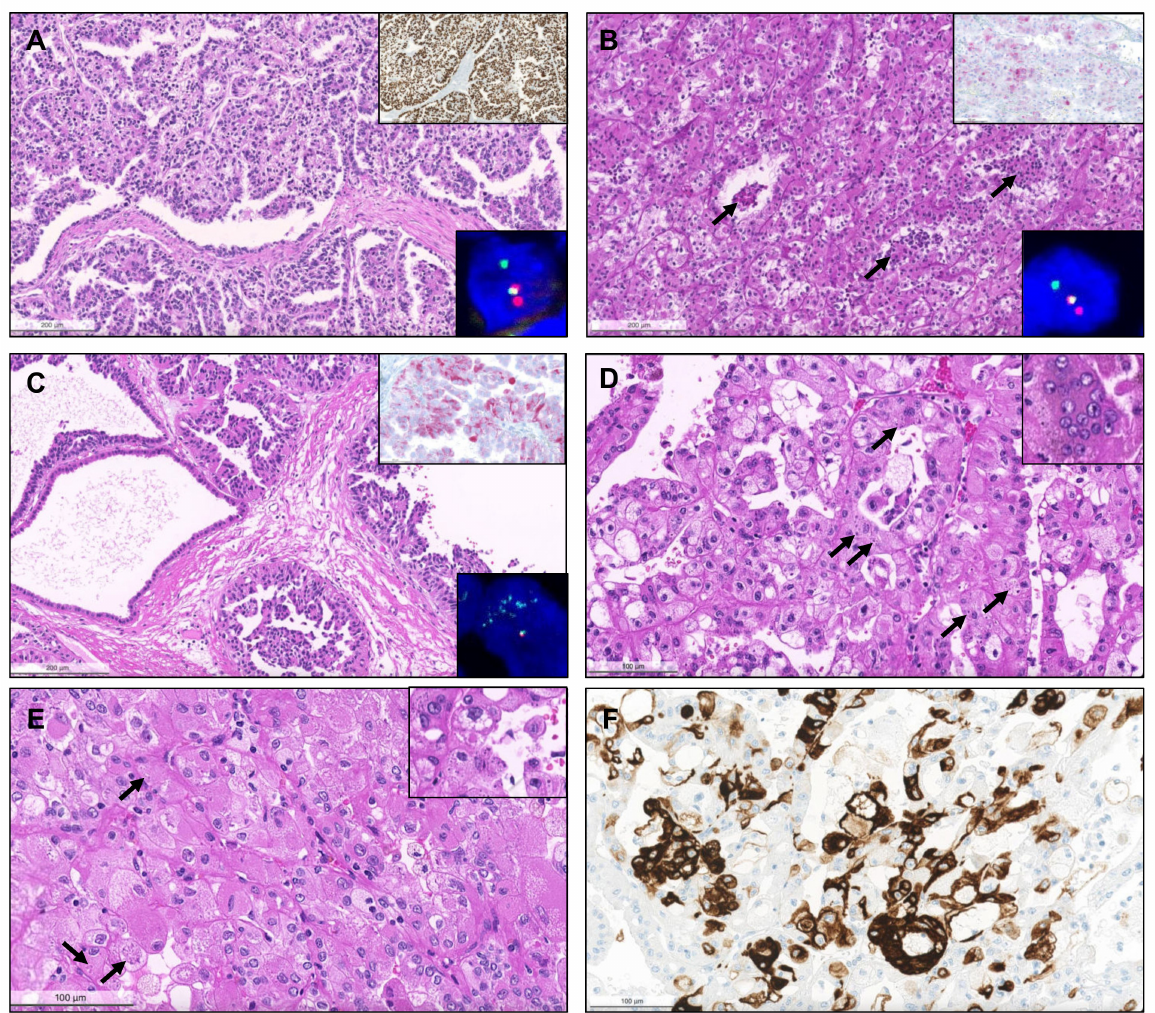
Figure 10. TFE3-translocated renal cell carcinoma. The tumor shows papillary architecture and clear cells ( A ) but can present with any morphology. Strong, diffuse positivity for TFE3 by immunohistochemistry strongly suggests the diagnosis (inset, right upper corner), which was confirmed by break-apart FISH (inset, right lower corner). TFEB-translocated renal cell carcinoma. Notice the admixture of clear cells and eosinophilic cells, also with the presence of a second population of smaller cells in clusters, focally surrounding or disposed within eosinophilic basement membrane material (( B ), arrows). Positivity for Melan-A supports the diagnosis (inset, right upper corner), which was then confirmed by break-apart FISH (inset, right lower corner). TFEB-amplified renal cell carcinoma. The tumor showed a partly cystic, partly papillary architecture, with predominance of eosinophilic cells with prominent nucleoli ( C ). Melan-A was diffusely positive (inset, right upper corner) and the amplification was confirmed by FISH (inset, right lower corner). Eosinophilic solid and cystic renal cell carcinoma. Both tumors represented in ( D ) and ( E ) were solid and cystic, but also showed areas with papillary projections. The tumor cells were densely eosinophilic, with focal small clear vacuoles, and the typical basophilic cytoplasmic inclusions (stippling) were easily found at high power magnification (( D ), arrows). There were also multinucleated eosinophilic cells (inset). Notice that many tumor cells are very large and “puffy”, with granular eosinophilic cytoplasm, and many nuclei are eccentric (contrarily to oncocytomas, where they are mostly centered). The nucleoli were prominent in some tumor cells, and both basophilic and slightly eosinophilic cytoplasmic granular inclusions (arrows) were seen ( E , highlighted in the inset). The tumors showed strong multifocal positivity for CK20 ( F